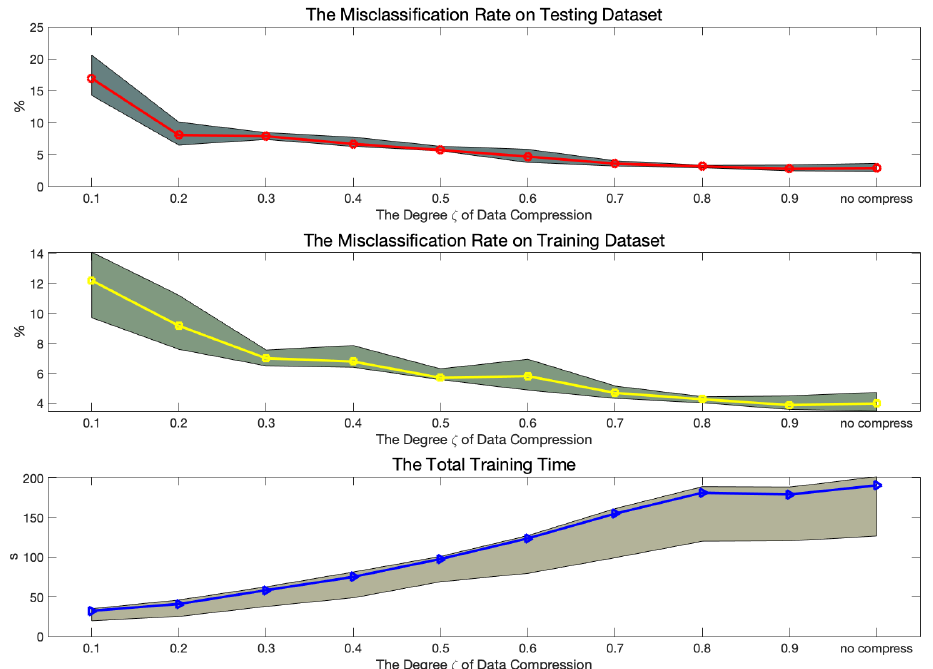
Figure 10. The performance trend with the increasing degree of data compression ζ . The top two pictures show the error rates on the testing and training datasets. The bottom picture is the whole training time. The shaded parts represent the Quartile range from 0.25 to 0.75.